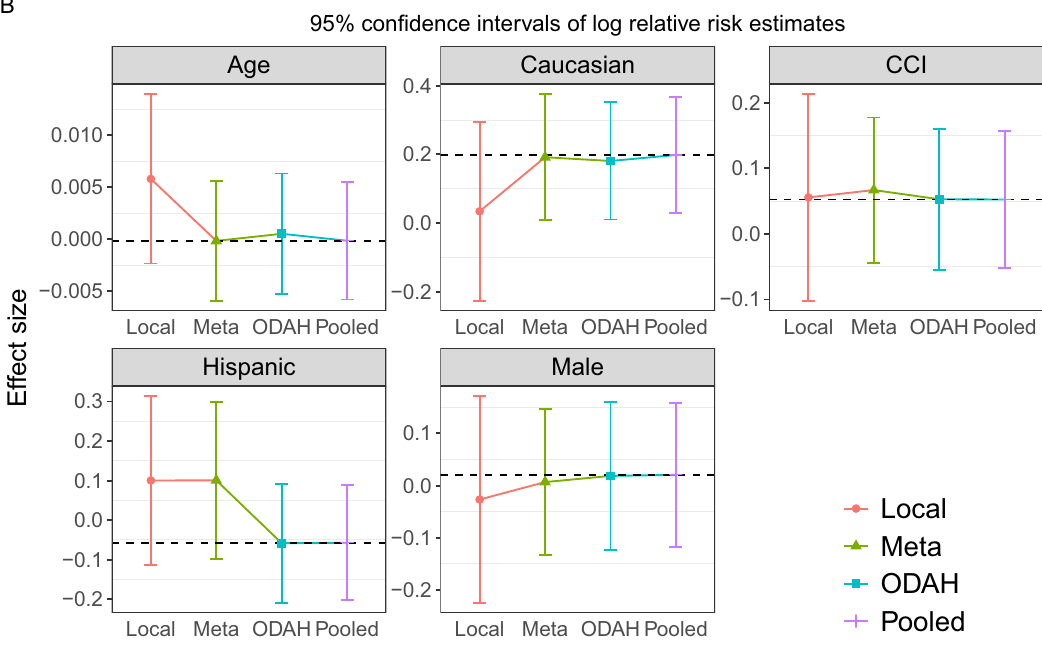
Figure 7. Plots depicting results from OneFlorida serious adverse event application. Log odds ratio ( A ) and log relative risk ( B ) estimates (along with corresponding 95% confidence intervals) for each covariate in the fitted hurdle model. Dashed horizontal line represents pooled estimate, our gold standard for comparing